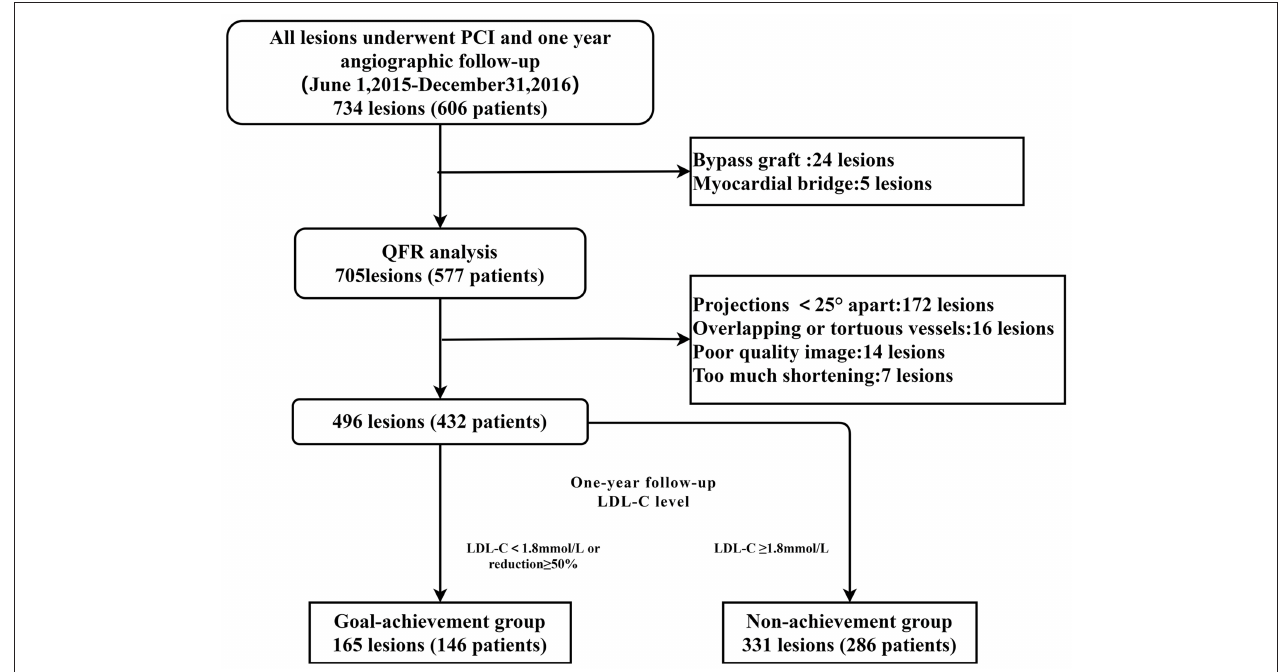
FIGURE 1 | Study flowchart. Among 734 lesions in 606 patients who underwent PCI, 705 lesions in 577 patients were analyzed by QFR. Of those, 172 lesions lacked two optimal angiographic projections at least 25 ◦ apart, 16 lesions were overlapping or tortuous, and 14 lesions in patients with poor-quality images were excluded. The other seven lesions were excluded due to excessive shortening lesions. Consequently, 496 lesions in 432 patients were analyzed in this study. According to the LDL-C level at the time of the 1-year follow-up, 165 lesions in 146 patients and 331 lesions in 286 patients were assigned to the goal-achievement and non-achievement groups, respectively. QFR, quantitative flow rate; PCI, percutaneous coronary intervention; LDL-C, low-density lipoprotein cholesterol.